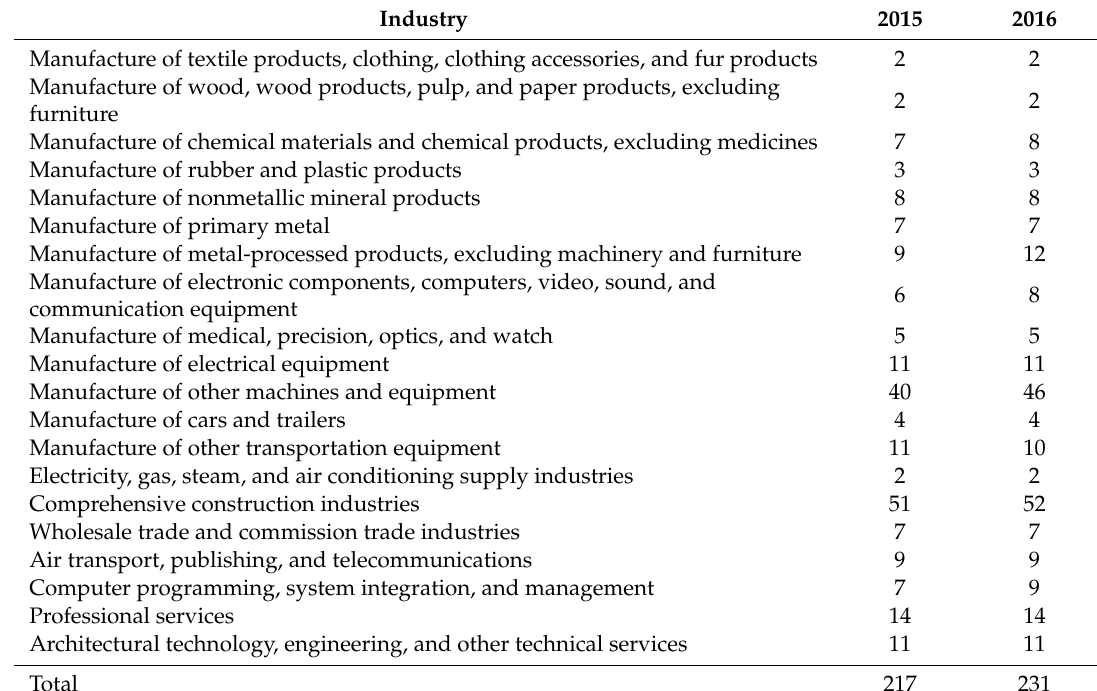
Table 1. The Year-Industry Distribution of the